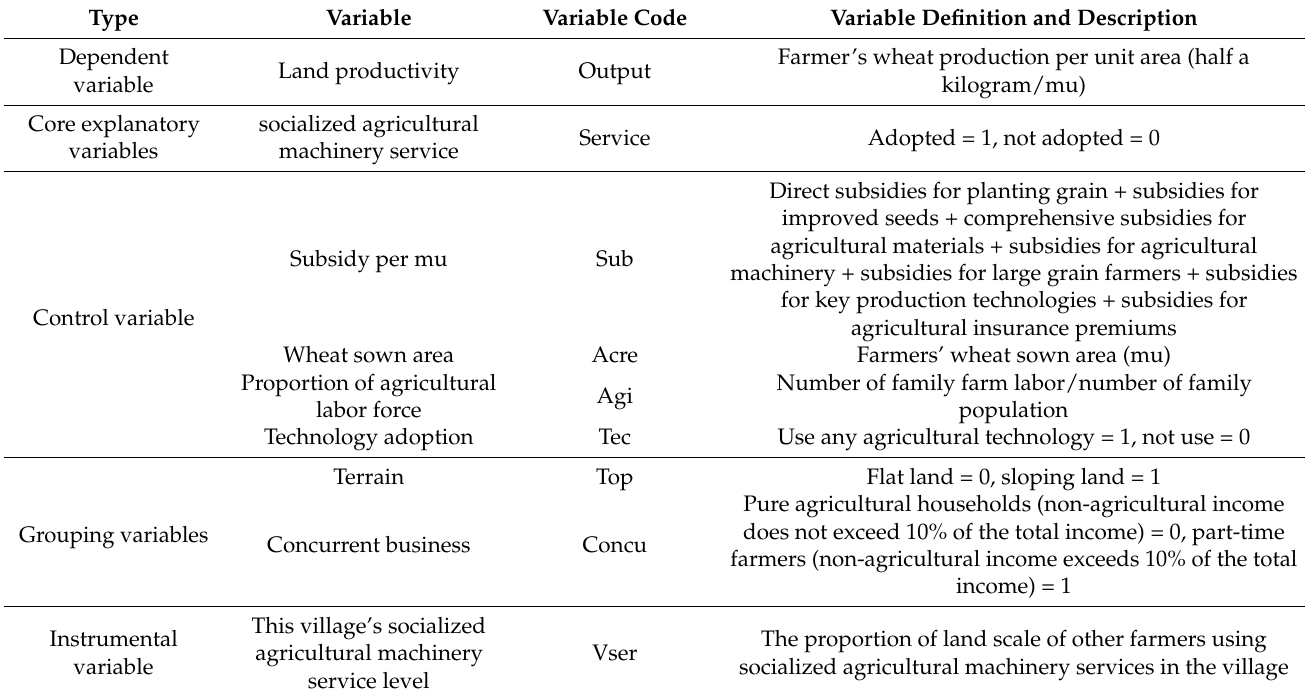
Table 1. Variable definitions and descriptive statistics.